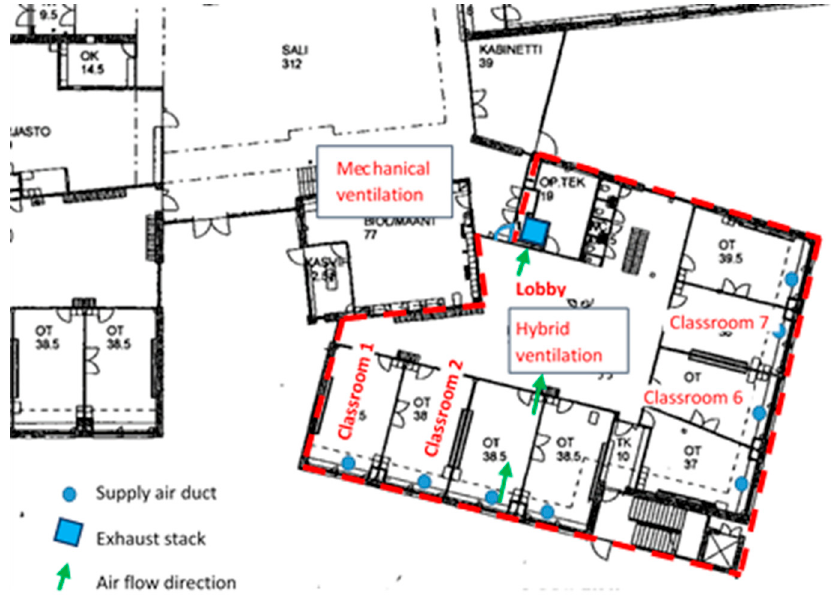
Figure 1. The studied building section (first floor) and locations of the supply air ducts and exhaust stack. Air flow direction is shown by arrows as an example in one classroom. Measurements were conducted mainly in Classrooms 1 and 2.